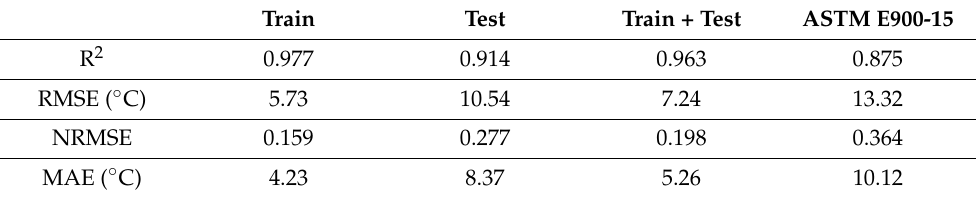
Table 3. Scores (R 2 , RMSE, NRMSE and MAE) obtained with the tuned GB model in the train, test and train + test datasets. The last column shows the scores obtained using the predictive model of ASTM E900-15.